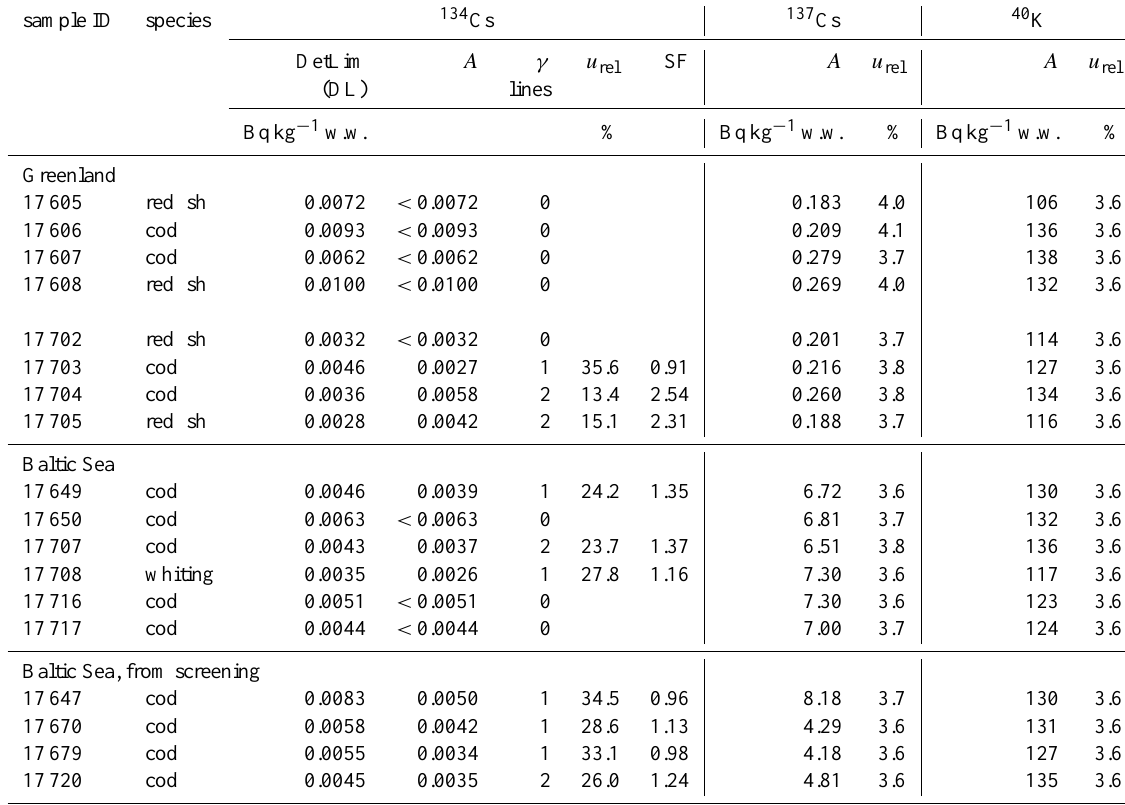
Table 2. Decay-corrected activity concentrations A of 134 Cs, 137 Cs and 40 K and associated relative uncertainties ( u rel ) in fish fillet samples from the Greenland and BS sites; the decision threshold DT (not shown) is well approximated by the value DL/1.548; SF is a significance factor, i.e. the ratio A /DT; “non-detects” are documented as <